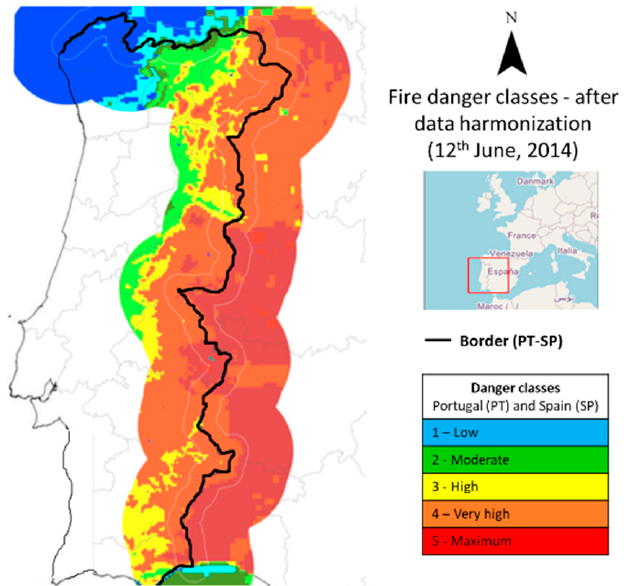
Figure 7. Classification of the danger level based on FWI in the transboundary area between Portugal (PT) and Spain (SP) in 12 June 2014—after data harmonization. The black line represents the border between PT and SP.